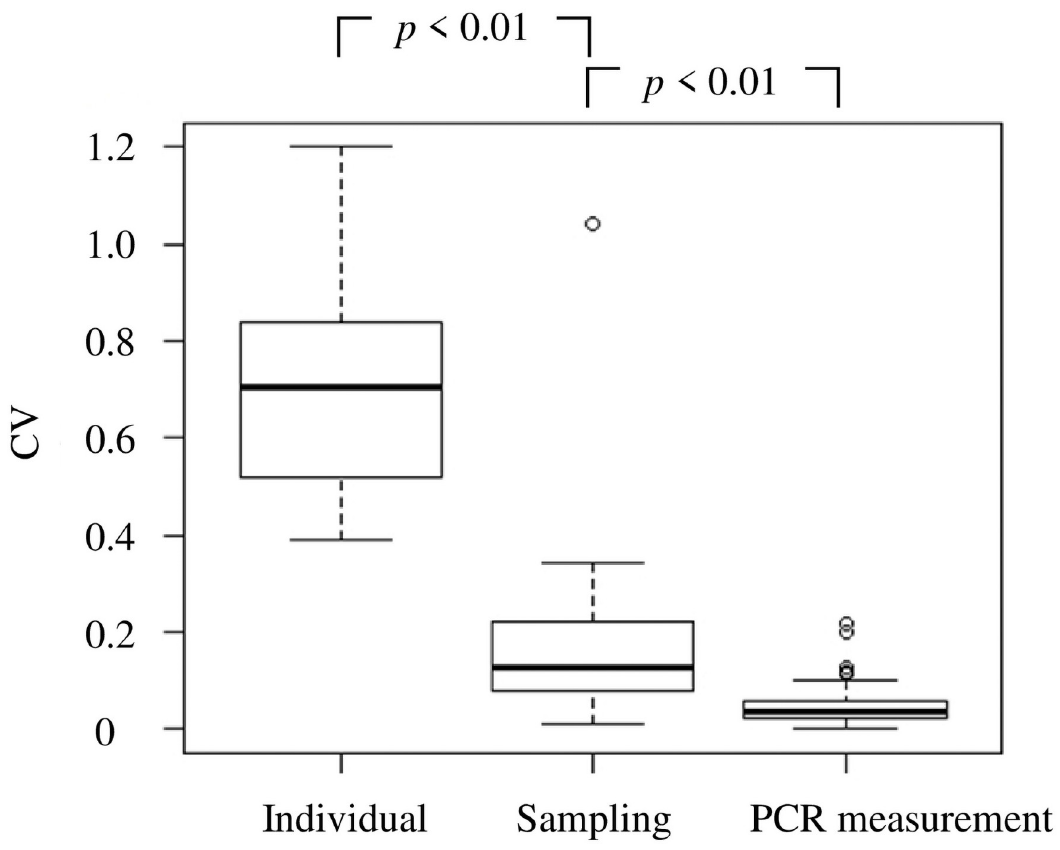
Fig 5. Coefficients of variation (CV) in individual, sampling, and PCR measurement replications. The CV significantly differed ( df = 2, p < 0.01, Kruskal-Wallis and Dunn-Bonferroni multiple comparisons tests).